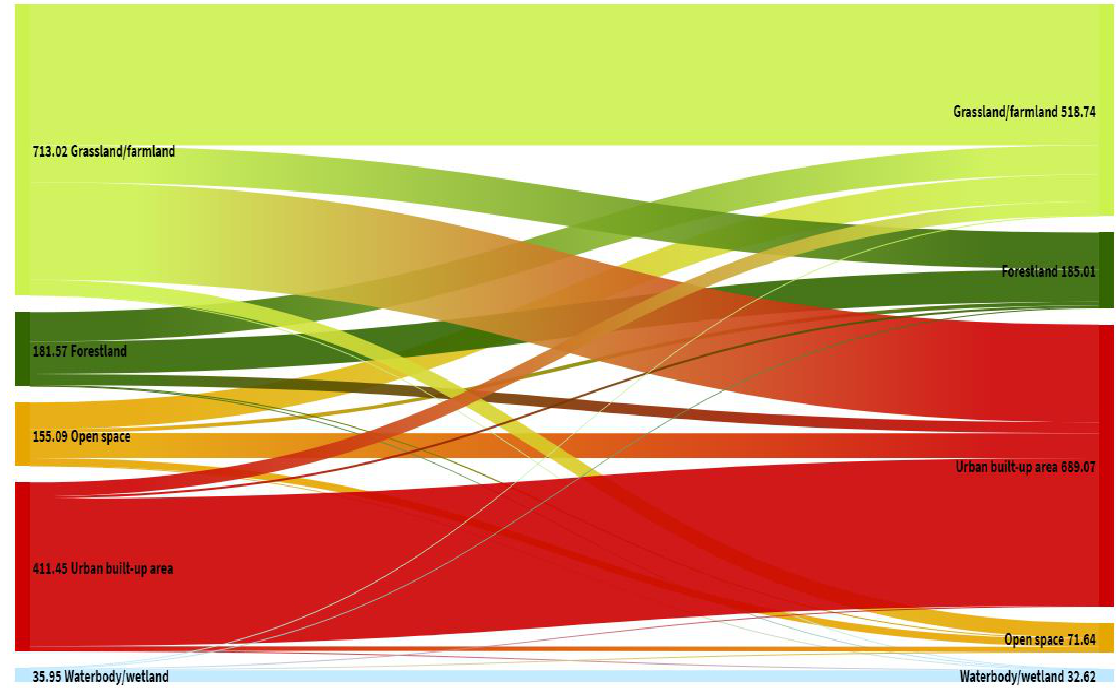
Figure 3. Land-use flows in GAMA, from 2008 (left panel) to 2017 (right panel).